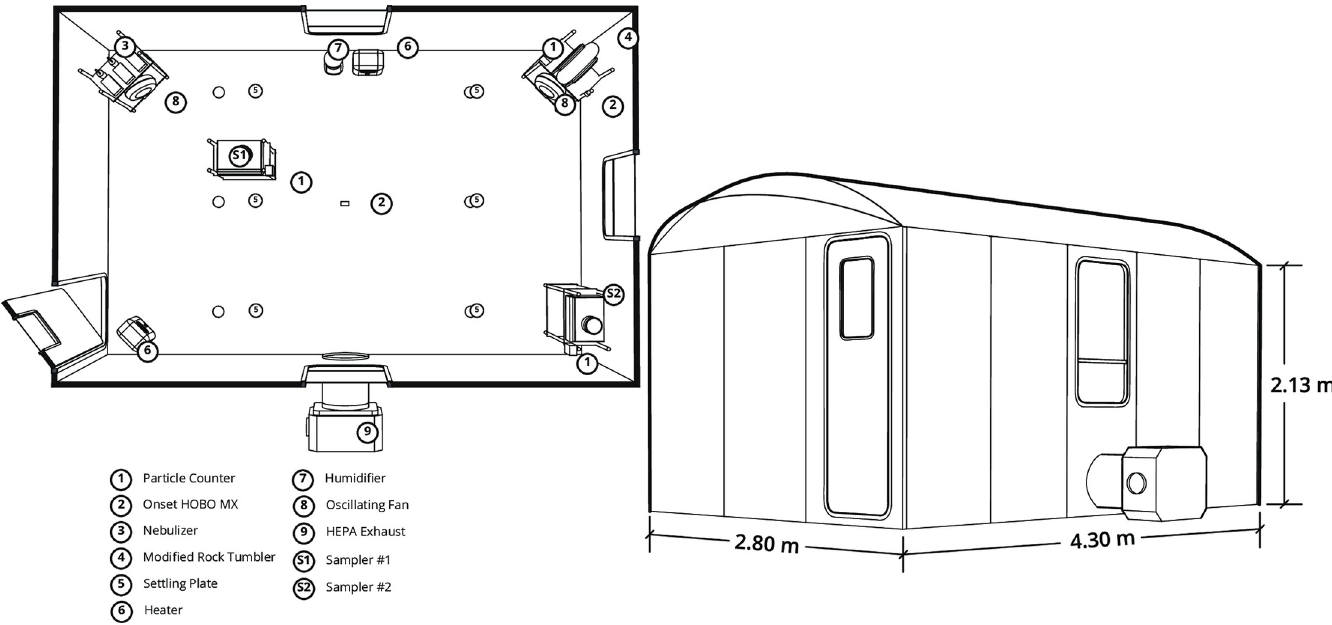
Fig 2. Layout of environment, AerosolSense samplers, and dimensions for room-scale aerosol testing.